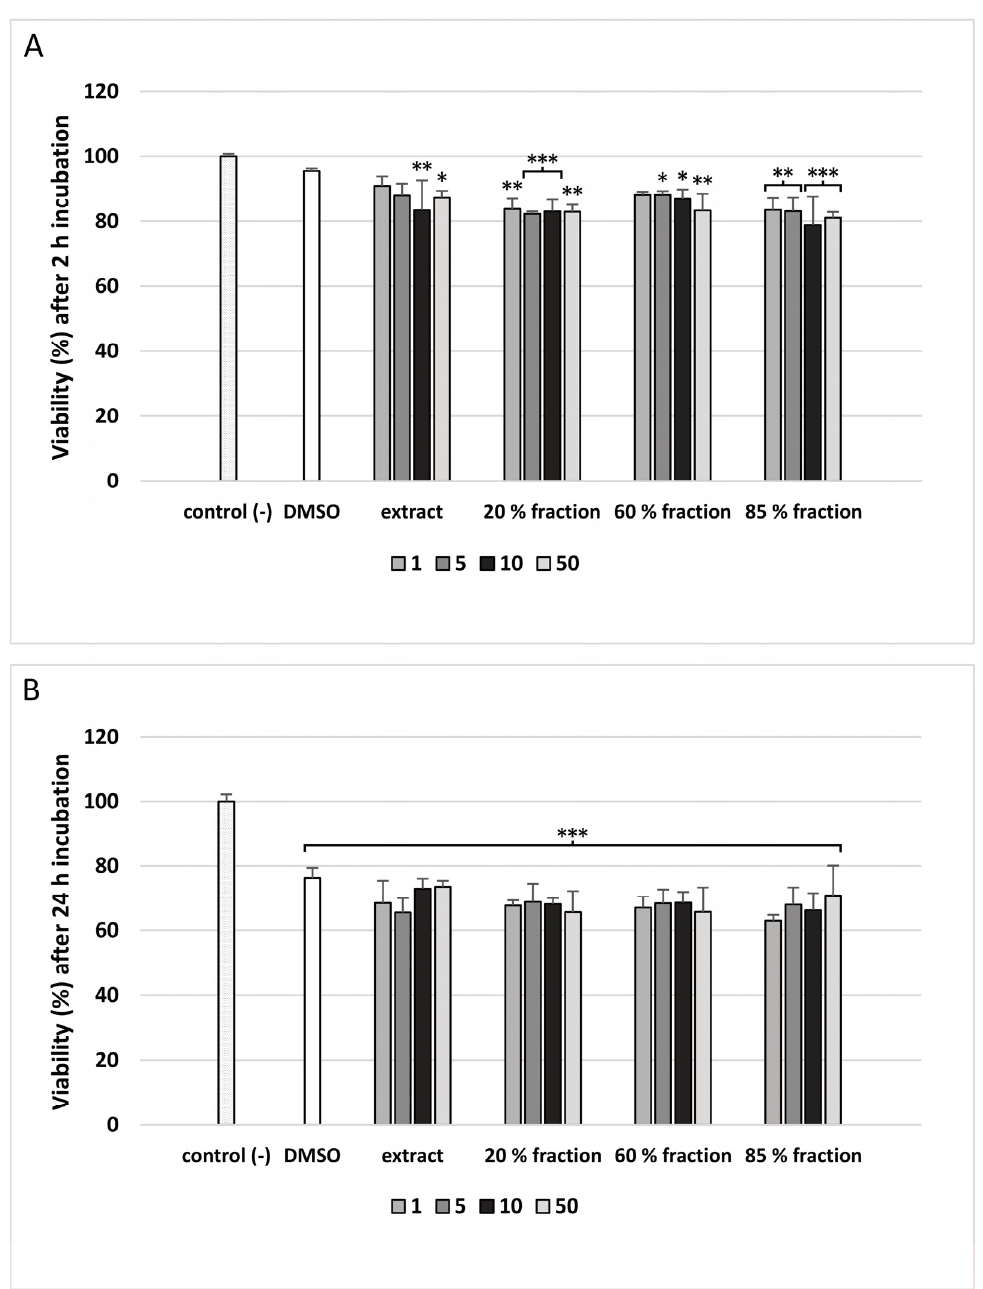
Figure 5. The effect of extract and fractions (20%, 60% and 85%; concentration range 1–50 µ g/mL) on the viability of PBM cells. The cell viability of PBM cells was measured after 2 h ( A ) and 24 h ( B ) incubation with extract and fractions. Data represent means ± SD of 3 experiments (from different donors). * p < 0.05, ** p < 0.01, *** p < 0.001 compared with control ( − ).